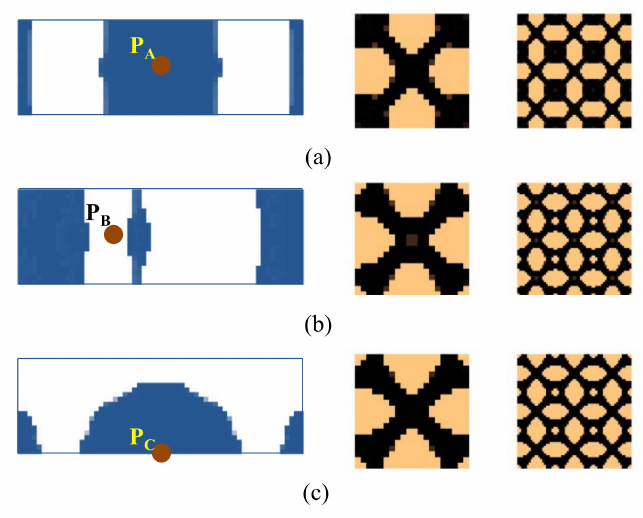
Figure 17. Design results for different excitation positions. ( a ) Excitation position P A . ( b ) Excitation position P B . ( c ) Excitation position P C . The excitation frequency range is 50–100 Hz.